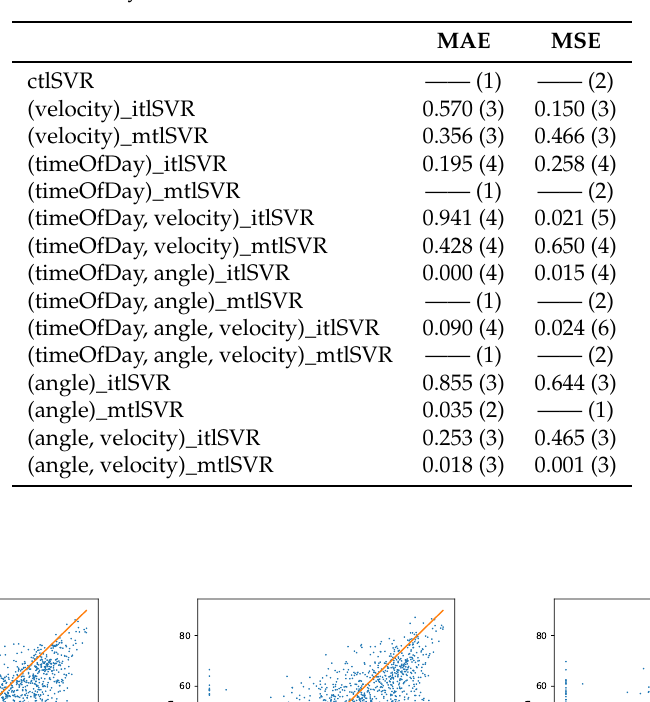
Table 6. Wilcoxon p -values and corresponding ranking for absolute (right) and quadratic (left) wind energy errors in Sotavento. The positions with hyphens correspond to the model ranked first in terms of MAE or MSE, as indicated by its column.